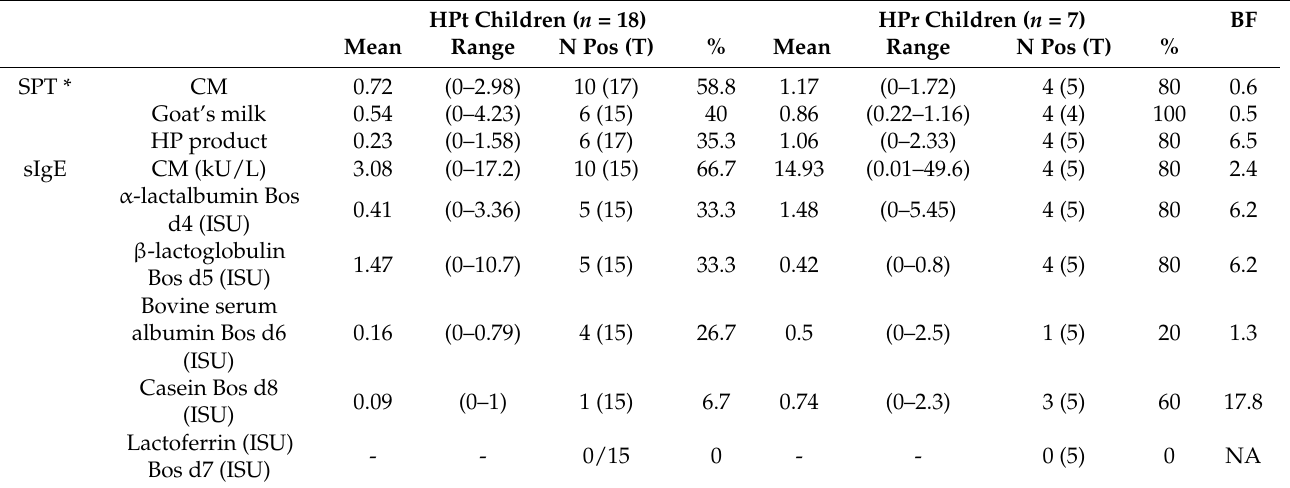
Table 3. Baseline sensitization profiles of the HP-product-tolerant (HPt) and HP-reactive (HPr) children.